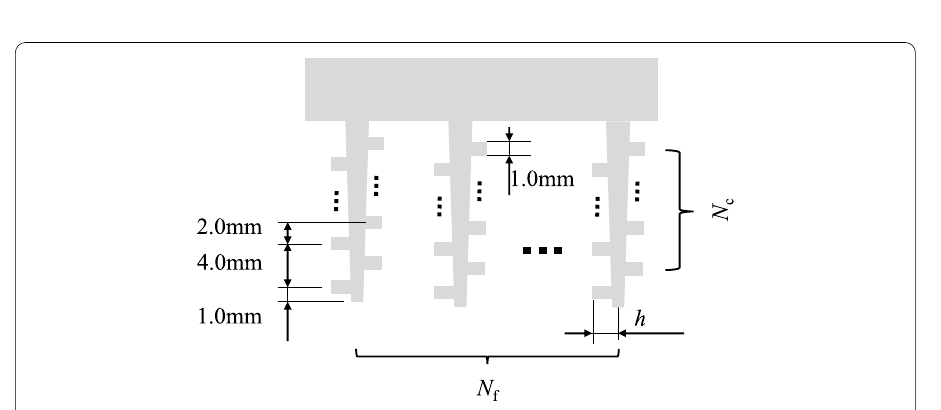
Fig. 3 Cross view of the modified heat sink with MCRFs